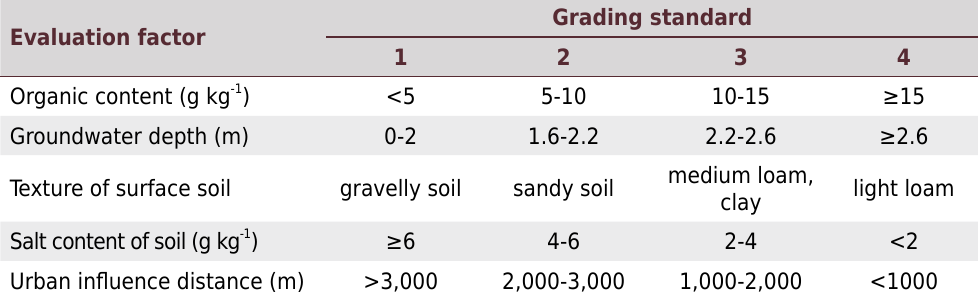
Table 2. Evaluation index values for cultivation suitability of unutilized land